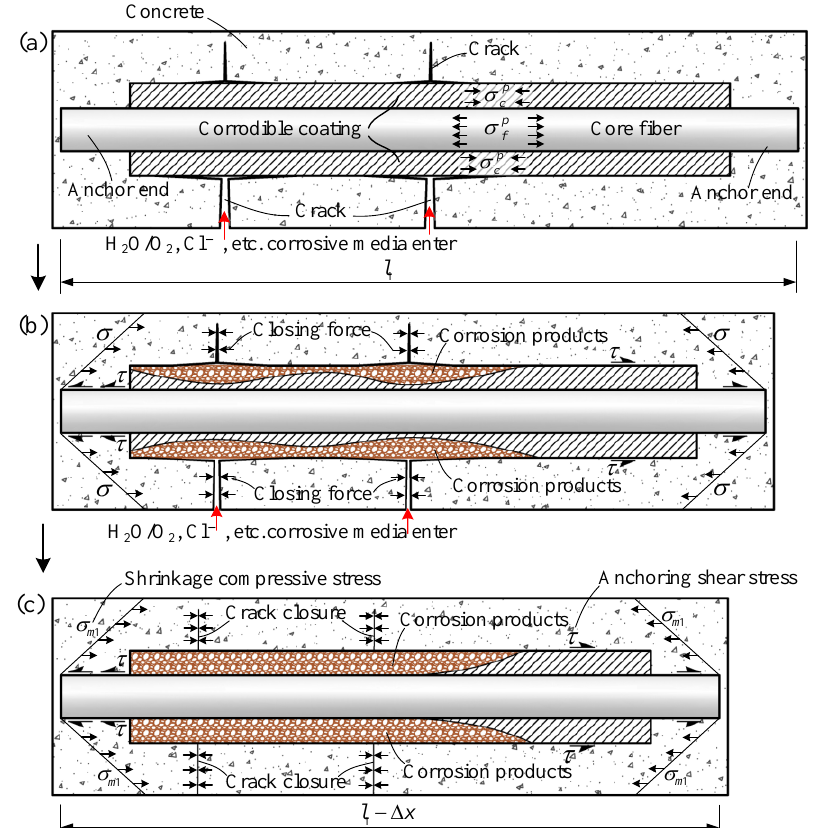
Figure 3. Axial cross-sectional view of the self-repair principle of the CIF composite, ( a ) corrosive media enter along the cracks and react with the corrodible coating, ( b ) CIF is triggered to shrink, the pre-stress stored in the core fiber is released to the matrix composite, ( c ) after the corrodible coating is corroded to a certain extent, the pressure applied to the matrix composite is large enough to close the cracks.